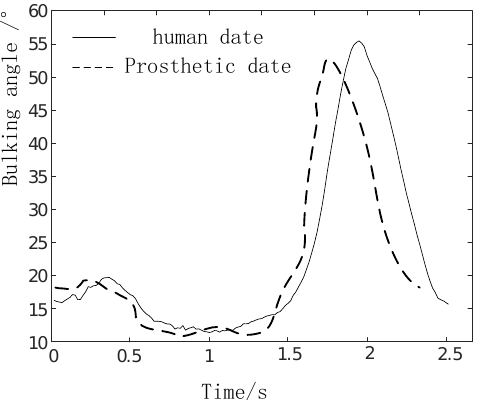
Figure 16. Comparison of knee prosthesis data and human data in walking gait.